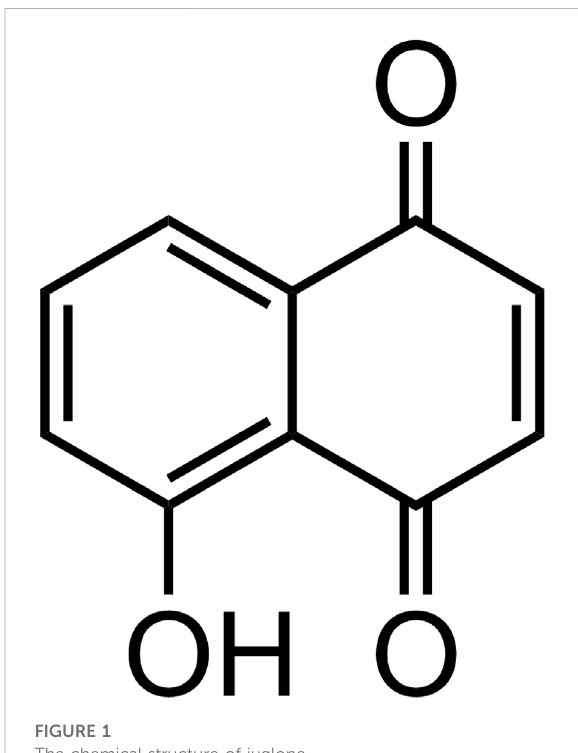
FIGURE 1 The chemical structure of